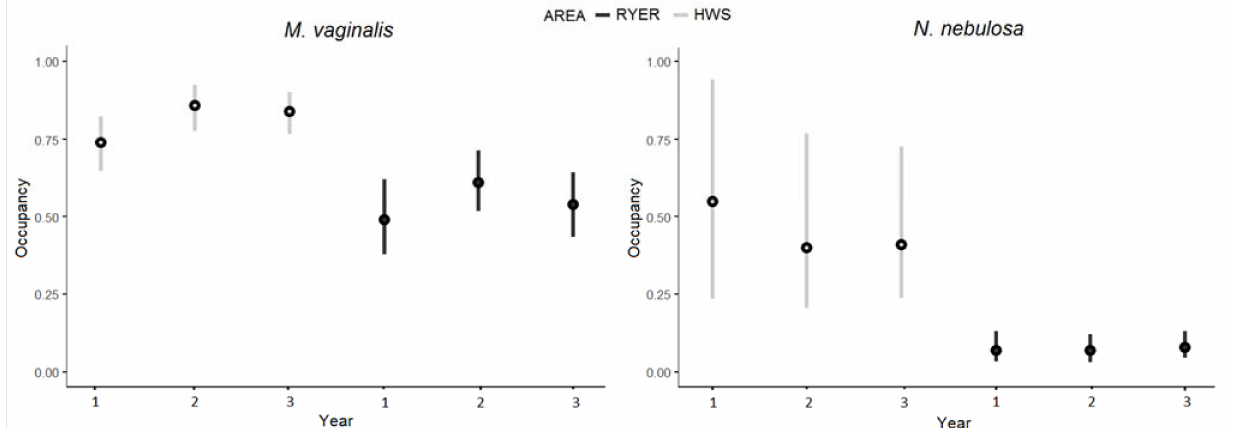
Figure 6. Occupancies values (y axis) for Muntiacus vaginalis and Neofelis nebulosa with median (black dots) and 95% Bayesian credible intervals for the three years of monitoring (x axis) in the two areas (grey: Htamanthi Wildlife Sanctuary (HWS); black: Rakhine Yoma Elephant Range